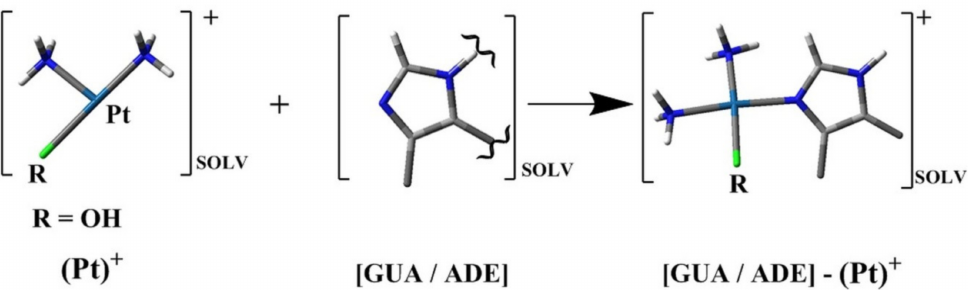
Figure 3. Scheme of the interaction of carboplatin with nucleobases. These processes lead to the creation of one and two positively charged complexes that react with the DNA bases forming a mono-functional adduct. The electron-rich site on DNA is the N 7 position on Guanine (Adenine) and 1, 2-GpG (1, 2-ApG). The majority of adducts formed by binding of carboplatin to Guanine (or Adenine) are intra-strand crosslinks (Figure 4).